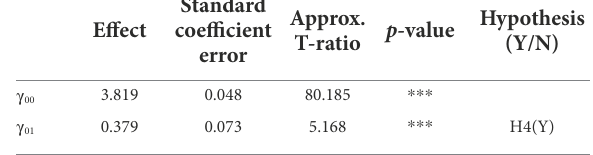
TABLE 4 Results of intercepts as outcomes model.